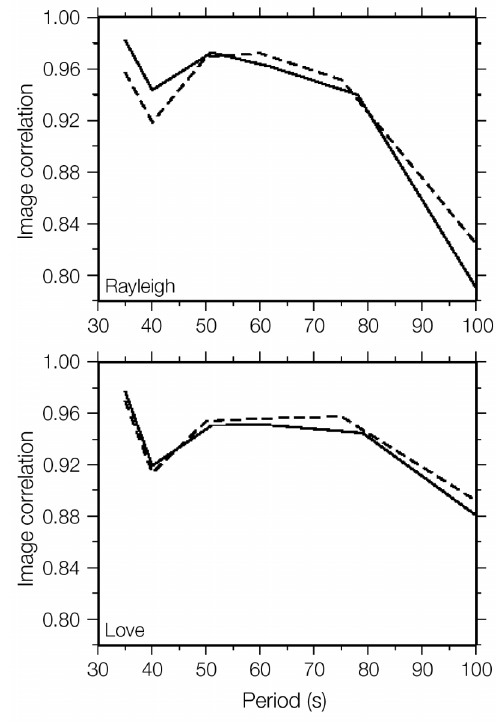
Fig. 5. Correlation between maps as a function of period, for Trampert and Woodhouse’s (2001) and Ekström et al. ’s (1997) databases (solid and dashed lines, respectively). Subsets of the two databases at Rayleigh ( top ) and Love ( bottom ) wave periods approximately 35 s, 40 s, 50 s, 60 s, 75 s, 100 s and 150 s are inverted with the 5° × 5° pixel parameteriza- tion of Section 3.1; the correlation of each of the re- sulting maps with the one, from the same database, at the neighbouring longer period is shown as a function of period. Correlation is computed according to Beck- er and Boschi (2002), and all harmonic degrees up to 40 are considered. For both Love and Rayleigh waves at short periods, maps from the Utrecht database are better correlated with each other than those from the Harvard one; the opposite is true at longer